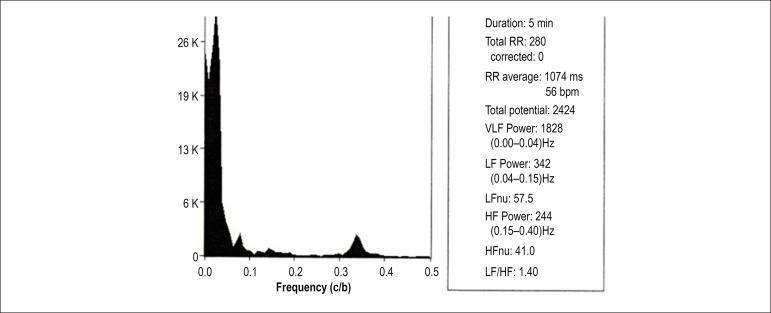
Spectral analysis of a male patient (67 years of age) with
orthostatic hypotension (same of Figure 1) in orthostatic position, showing a decrease in
low frequency (LF) component and in the LF/high frequency (HF)
ratio, in relation to supine position. RR: number of QRS in sinus
rhythm; VLF: very low frequency; HFnu: HF normalized unit.